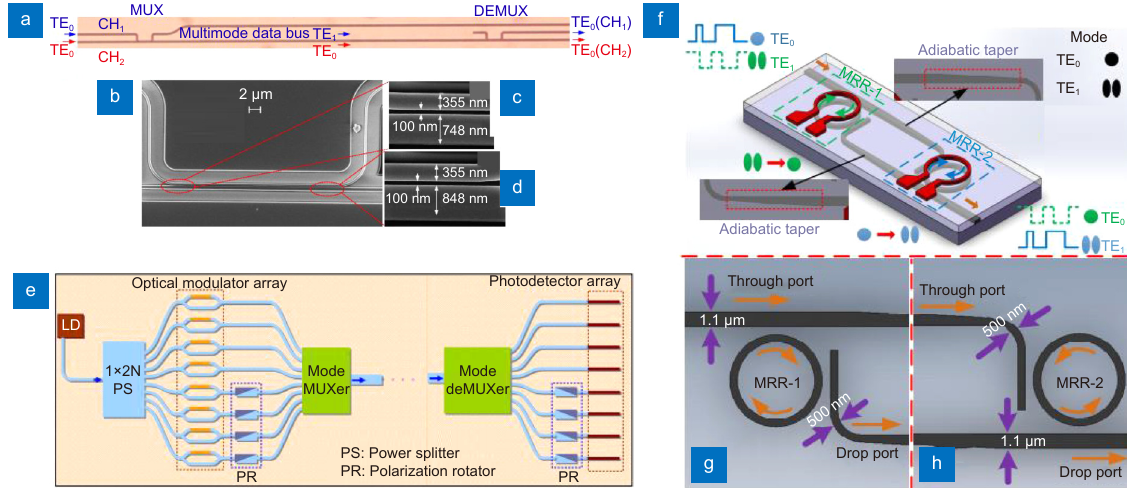
Fig. 11 | ( a ) Manufactured TE 0 and TE 1 mode MUX circuit. ( b ) SEM images of a manufactured TE 0 and TE 1 mode (de)MUX and details of its. ( c ) Input side. ( d ) Output side 91 . ( e ) Graphical representation of a multimode SDM circuit with two polarizations. ( f ) Schematic of the circuit and struc- tures of ( g ) μ-RRs-1, (h) μ-RR-2. Figure reproduced from: (a–d) ref. 91 , Optica Publishing Group, under the Optica Open Access Publishing Agree- ment; (e) ref. 92 , Optical Society of America; (f–h) ref. 93 , Optica Publishing Group, under the Optica Open Access Publishing